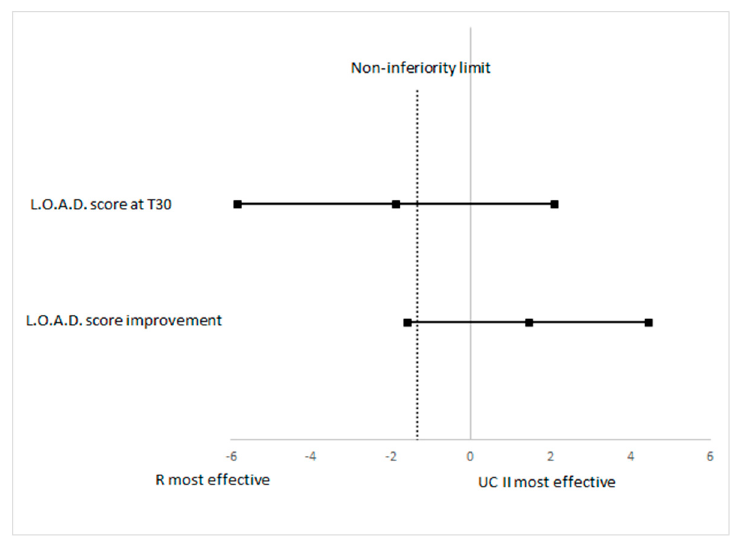
Figure 3. Plot of the 90% confidence limits of the di ff erence in LOAD score at T30 and of improvement in LOAD score between R and UCII groups. The vertical dashed line is the non-inferiority